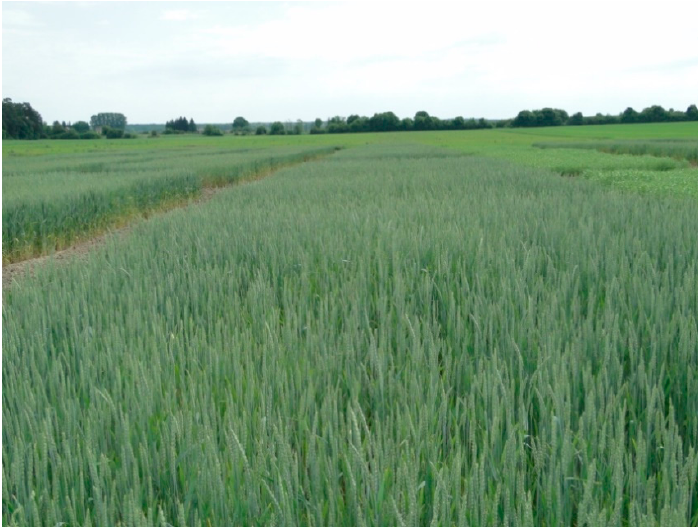
Figure 2. General view of the experiment. Winter wheat at the flowering stage (63–65 BBCH scale). Winter wheat ( Triticum aestivum L.) of Ozon cultivar was grown in three tillage systems: (1) Conventional (CT); (2) reduced (RT); and (3) no-tillage (NT). In the CT system, shallow ploughing (at